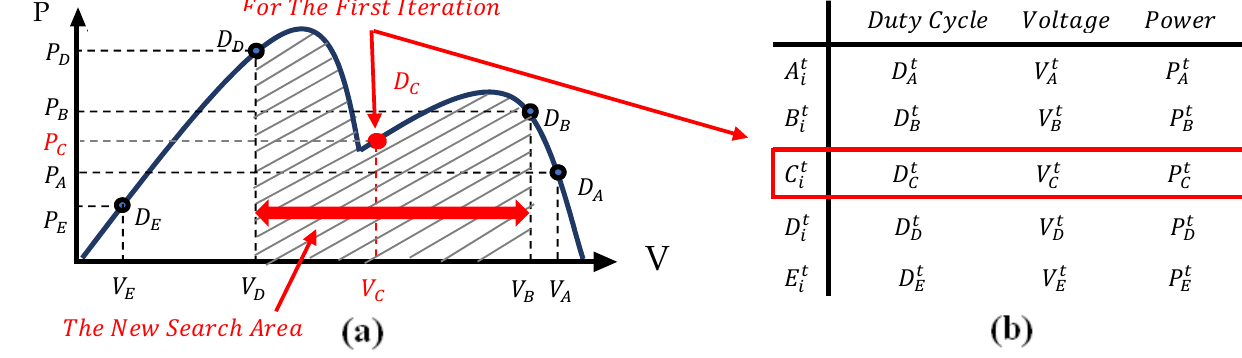
Figure 5. ( a ) The spread of the iteration’s operating points on the P-V curve. ( b ) The iteration’s data storage matrix.